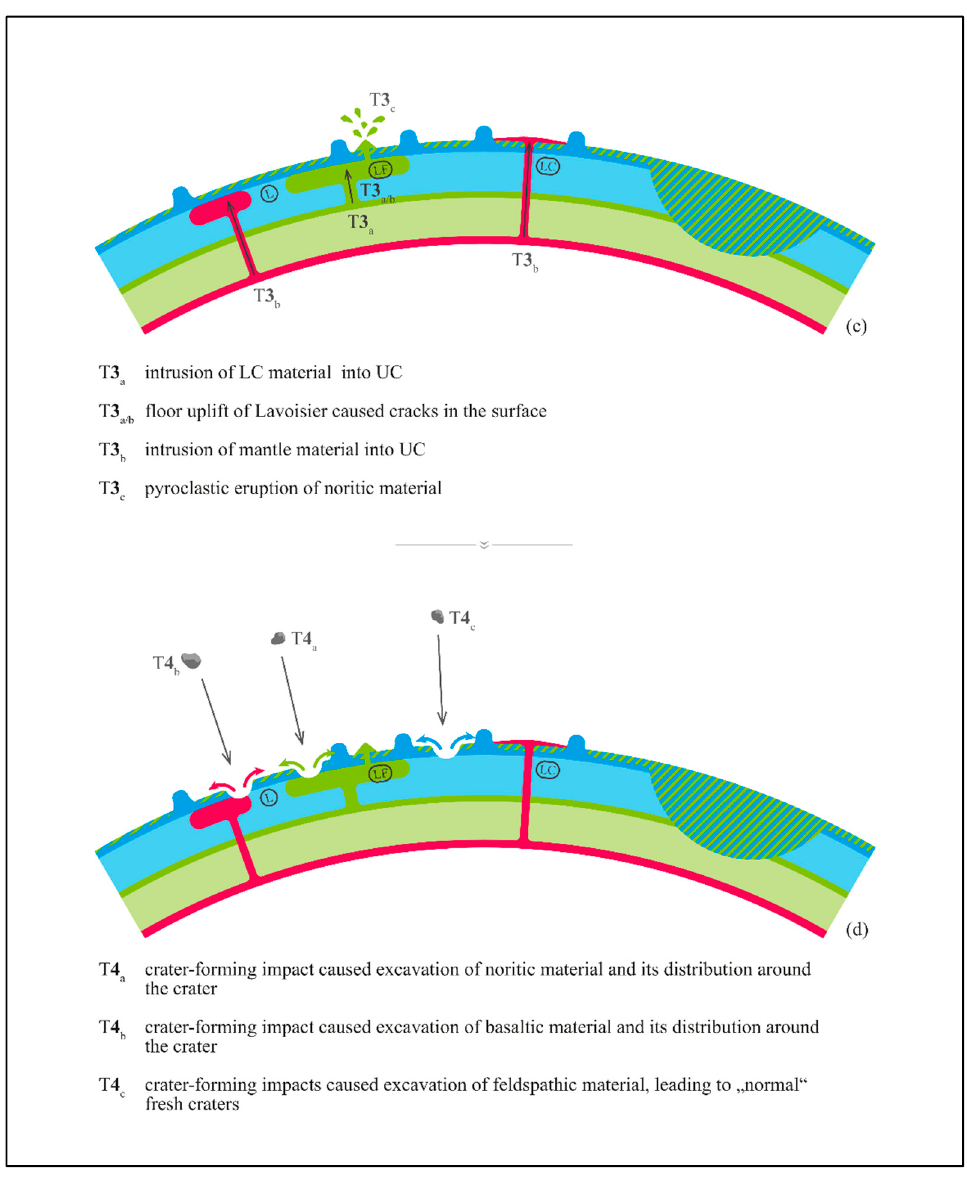
Figure 11. The schematic illustration of the proposed geologic processes that generated the mor- phological and petrological structures observed in the Lavoisier region. The times of occurrence of the events are denoted by T1 (first event) > T2 > T3 > T4 (most recent events). Letters mark events that occurred approximately simultaneously within each period and do not indicate a temporal sequence. ( a ) Period T1, formation of a nearby impact basin with norite-intermixed feldspathic ejecta. ( b ) Period T2, formation of Lavoisier and its large satellite craters. ( c ) Period T3, magmatic intrusion and flooding processes and pyroclastic eruption. ( d ) Period T4, formation of small impact craters ejecting basaltic, noritic or feldspathic material. For details, see Sections 1–4. The first event is the formation of one or several nearby large impact basins at time T1. This impact excavated noritic material from the lower crust together with feldspathic material from the upper crust, thus distributing norite-intermixed feldspathic ejecta across a large area near the border of Oceanus Procellarum, which appear in blue-green in our petrologic maps (see also Figure 12). Notably, the Mg-rich materials surrounding the major nearside mare areas were detected independently by Berezhnoy et al. [27] based on Lunar Prospector Gamma Ray Spectrometer data.